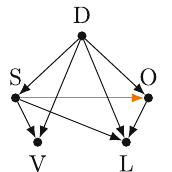
Figure 3: DAG for the sepsis prediction task. The orange edge denotes the unstable edge: lab test ordering policies vary across